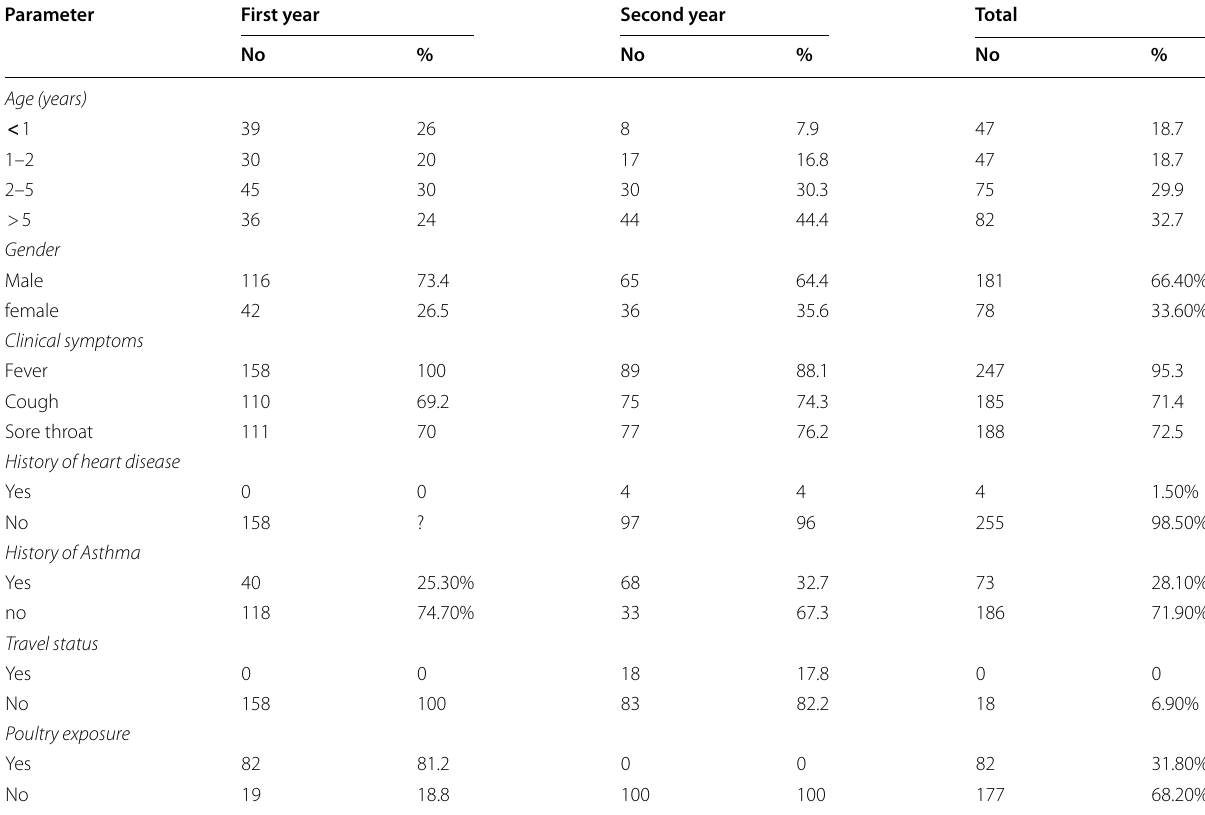
Table 2 Descriptive data of the studied